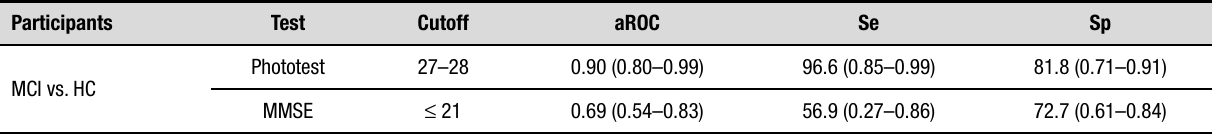
Table 2. Sensitivity and specificity of the Mini-Mental State Examination and the Phototest. Participants Test Cutoff aROC Se Sp MCI vs.